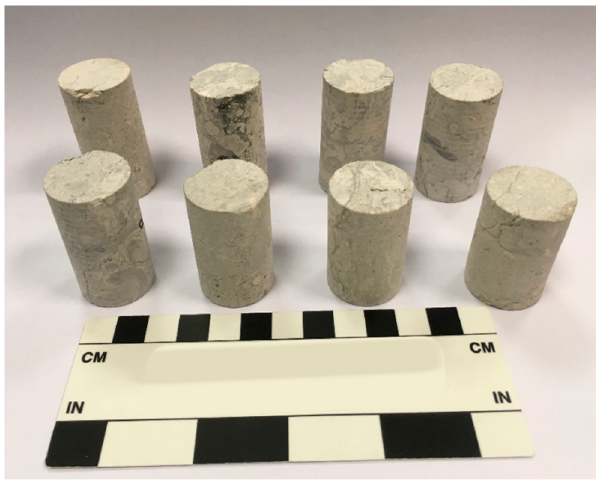
Figure 3. Core plugs used in laboratory measurements.